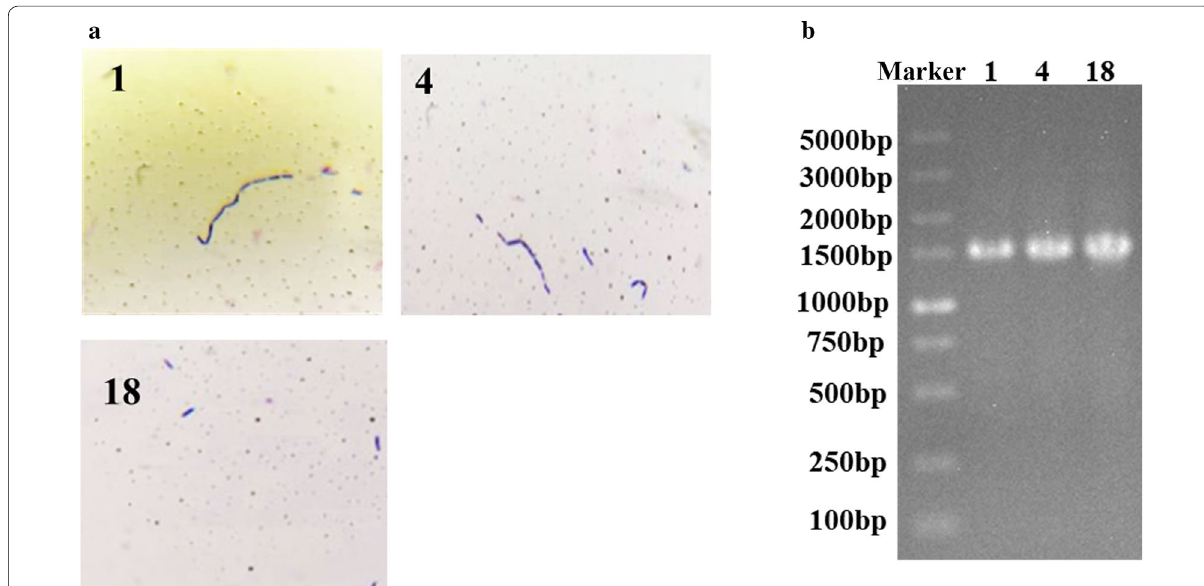
Fig. 2 The morphology and the 16S rDNA analysis of the isolated strains. The isolated strains were dyed and the morphology were observed ( a ). The amplified 16 s rDNA was analyzed by nucleic acid gel ( b )